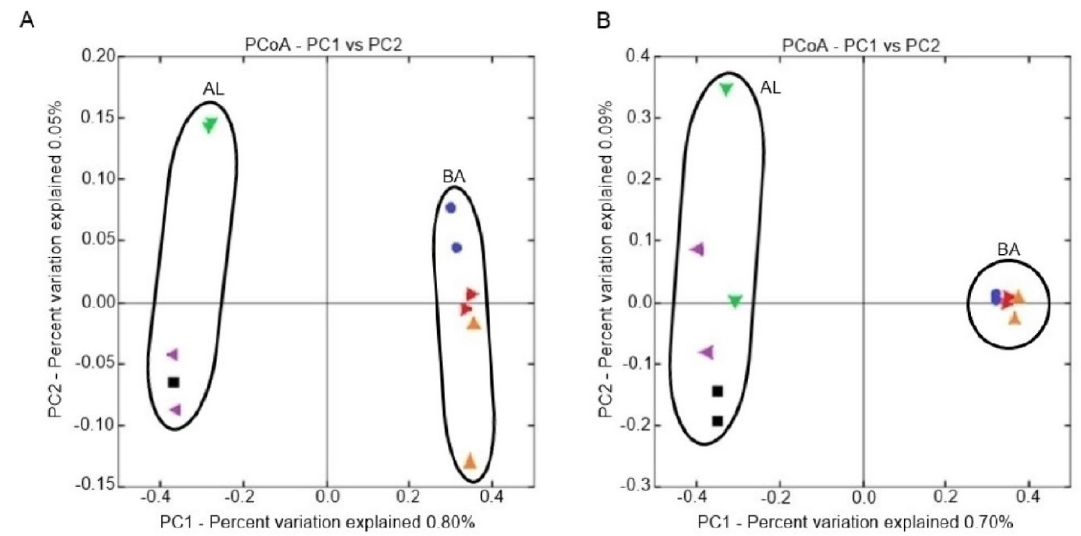
Figure 11. Principal coordinates analysis (PCoA) plots of the Bray-Curtis distances for soil bacterial ( A ) and fungal communities ( B ). Explanation: AL—Abruptic Luvisol, BA—Brunic Arenosol, green triangle—optimal dose of fertilizer AL, black square—optimal dose of fertilizer enriched with microorganisms AL, purple triangle-fertilizer enriched with microorganisms (dose reduced by 40%) AL, orange triangle—optimal dose of fertilizer BA, blue circle-optimal dose of fertilizer enriched with microorganisms BA, red triangle-fertilizer enriched with microorganisms (dose reduced by 40%) BA.